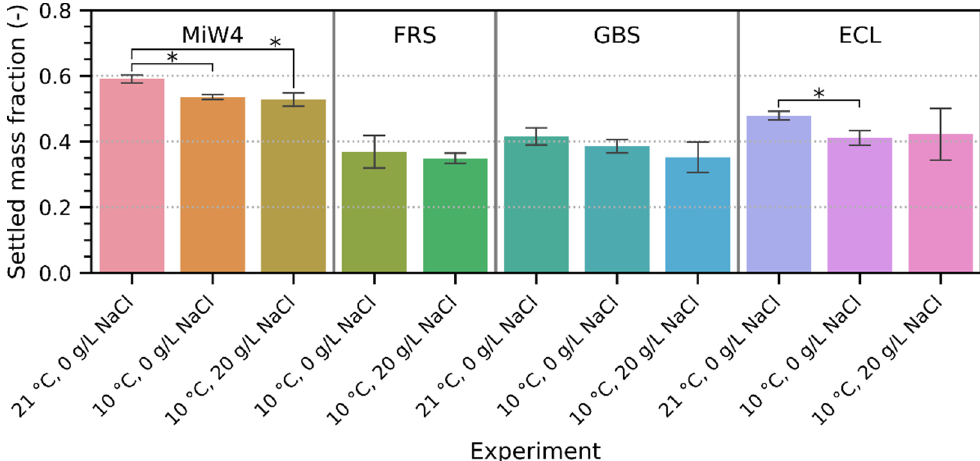
Figure 3. Settled mass fraction in the settling experiments with varying temperatures (21 and 10 °C) and NaCl concentrations (0 and 20 g/L); n = 3 for each experiment. The error bars indicate the standard deviation; the asterisks (*) indicate statistically significant differences between two experiments ( p < 0.05). Experiment FRS 21 °C 0 g/L NaCl was not conducted due to low sample quantity.